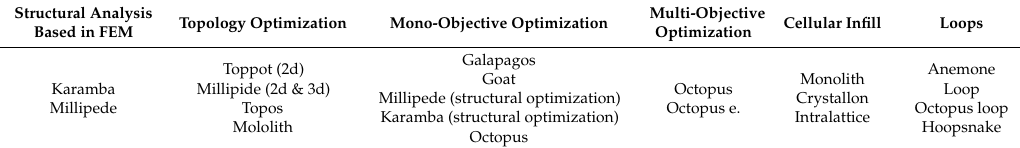
Table 1. Classification of plug-ins considered to be included in the